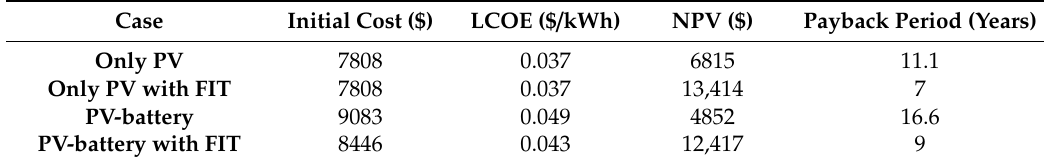
Table 5. Financial assessment for cases with / without battery and